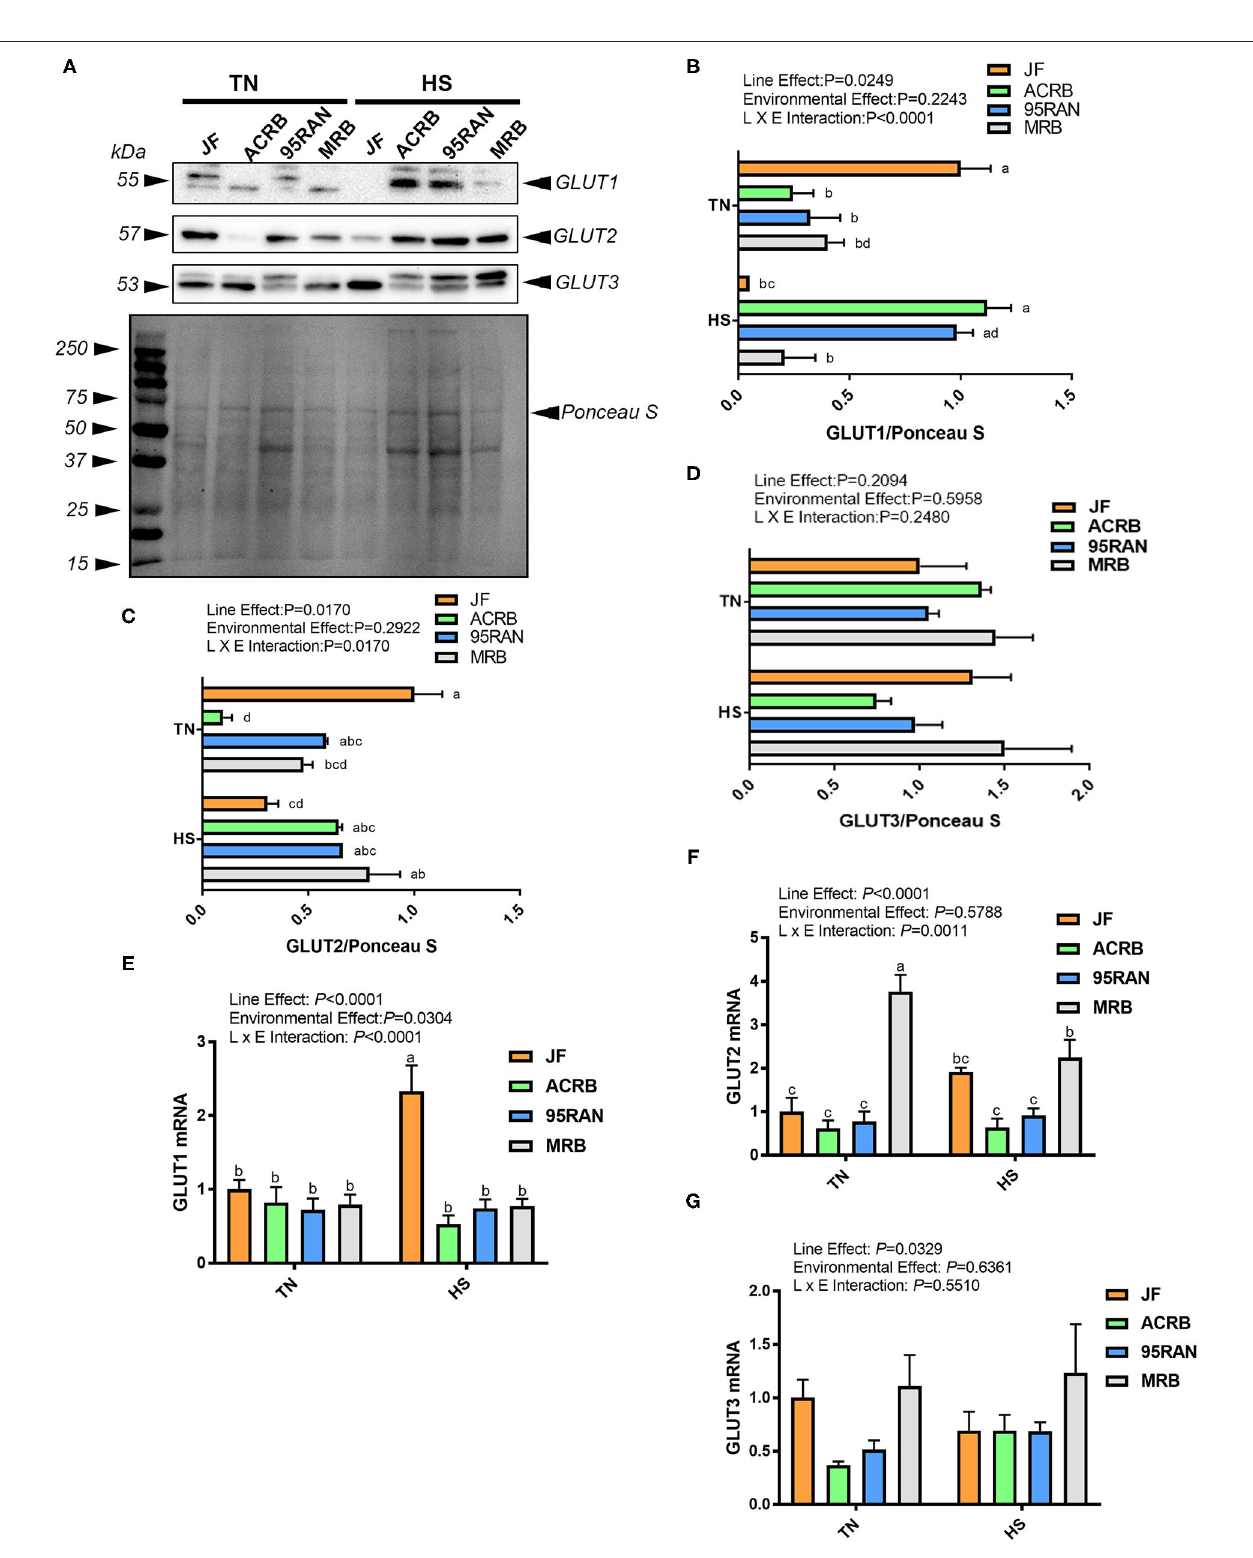
FIGURE 3 | Effect of HS on jejunal expression of GLUT1, GLUT2, and GLUT3 in JF, ACRB, 95RAN, and MRB birds. Protein and RNA were extracted from tissue and analyzed by western blot (A–D) and qPCR (E–G) , respectively. Gene expression data are mean ± SEM ( n = 6/group). Protein expression was normalized to loading via Ponceau stain (PS) (A) . Protein was analyzed via AlphaView software and is expressed as mean ± SEM ( n = 4/group) with one representative blot shown (A) . Different letters indicate the significant difference at P < 0.05. GLUT, glucose transporter; HS, heat stress; TN, thermoneutral; JF, jungle fowl; ACRB, Athens Canadian Random Bred; 95RAN, 1995 random bred; MRB, modern random bred.